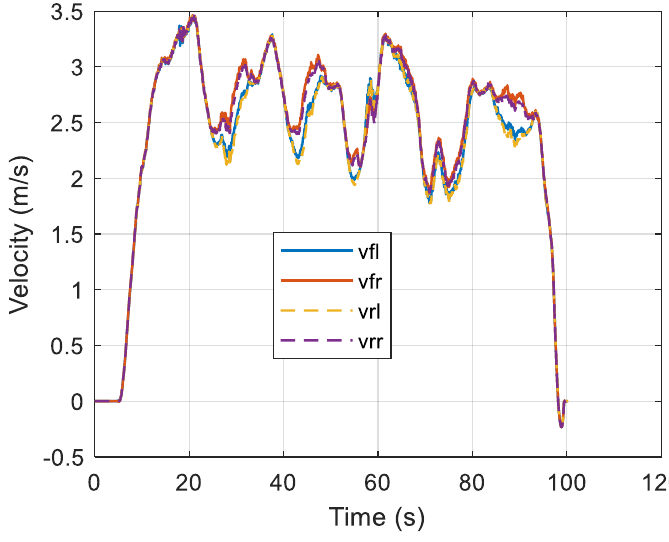
Figure 4. Speeds of the four wheels as functions of time.